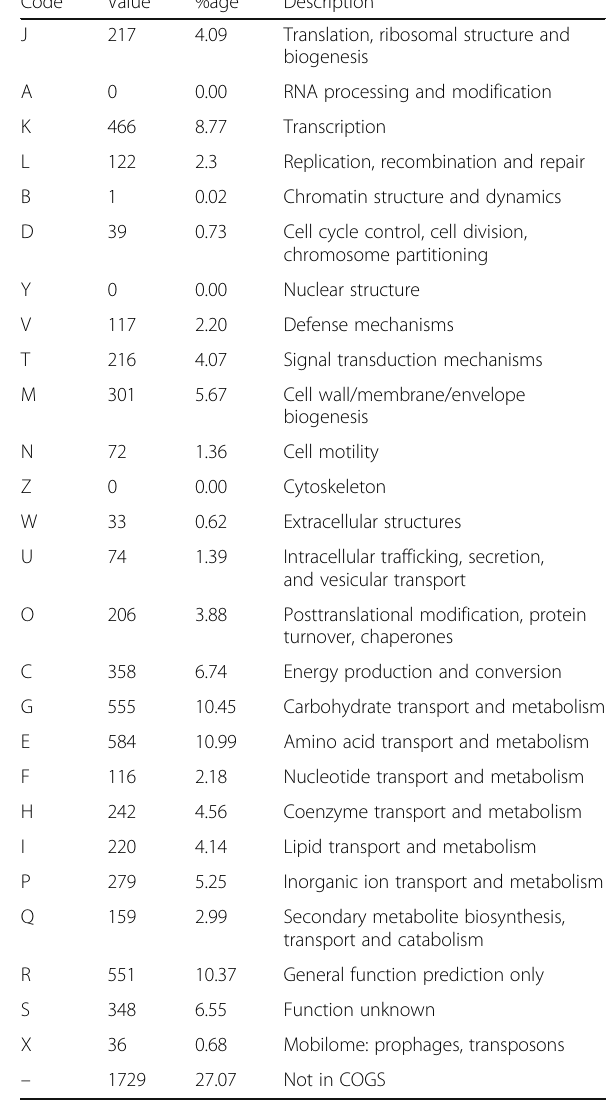
Table 4 Number of genes of Ensifer meliloti Mlalz-1 associated with the general COG functional categories